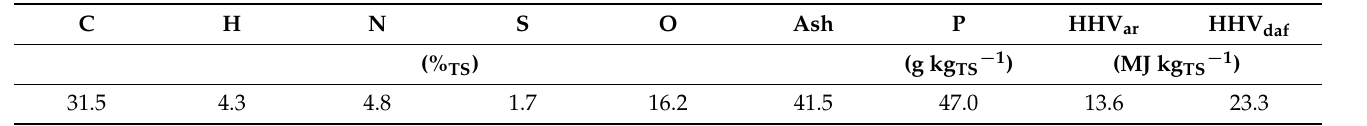
Table 1. Characterization of the used digested sewage